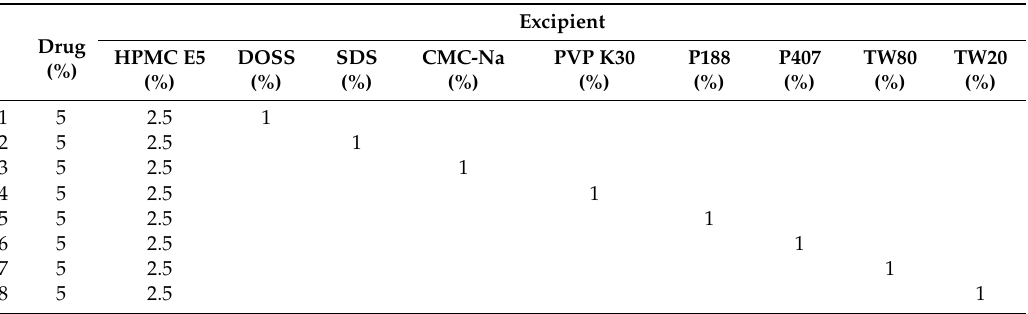
Table 3. Composition of the